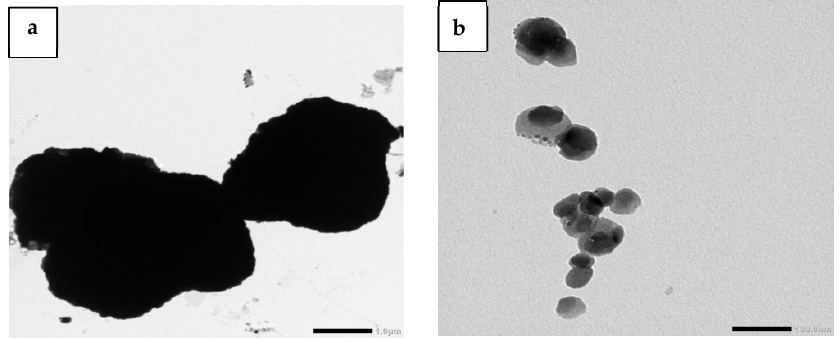
Figure 2. TEM images of ( a ) PbO microparticles, and ( b ) PbO nanoparticles.